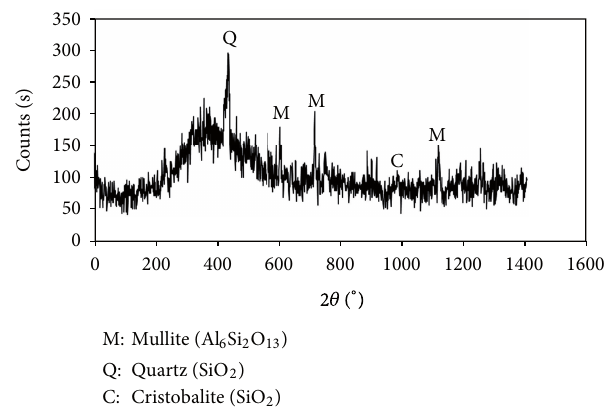
F 24: X-ray diffraction of activated carbon-�y ash-nSiO composite